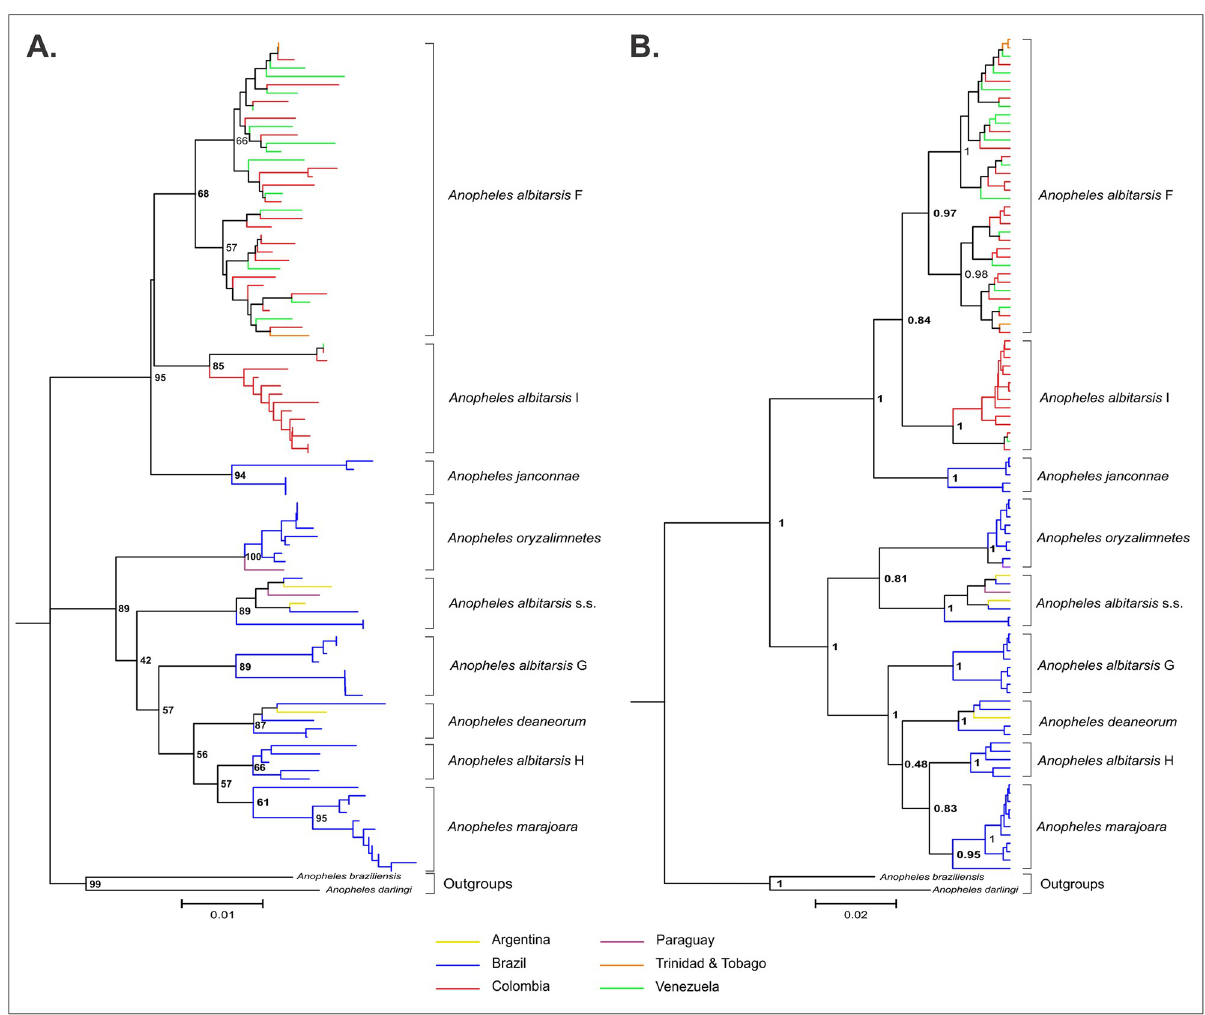
Fig 2. Phylogeny of Anopheles albitarsis complex in South America. A . Bootstrapped NJ tree based on 1000 replicates of K2P data matrices from 100 sequences dataset. B . Bayesian inference tree based on posterior probabilities. Outgroup taxa include An . darlingi (GenBank: DQ076236) and An . braziliensis (GenBank: DQ076238). Color-coding represents the country of origin of MT-CO1 sequences taxa.